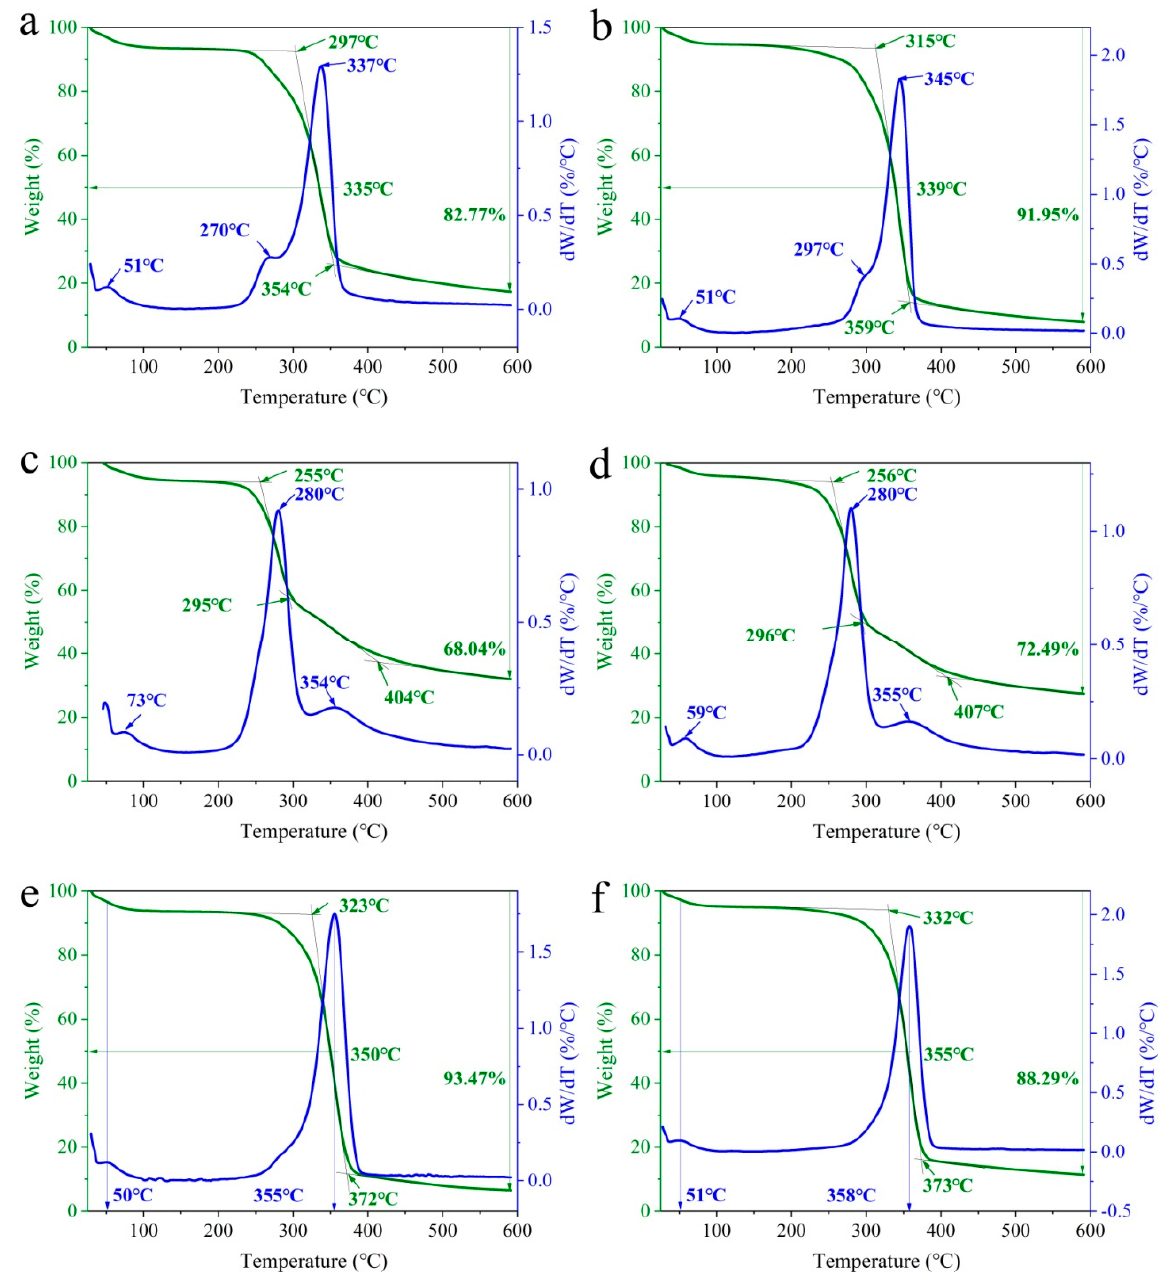
Figure 4. TG of paper samples untreated and treated with EO-Ar. ( a , b ) untreated and treated sample 1 with EO-Ar, ( c , d ) untreated and treated sample 2 with EO-Ar, ( e , f ) untreated and treated sample 3 with EO-Ar.